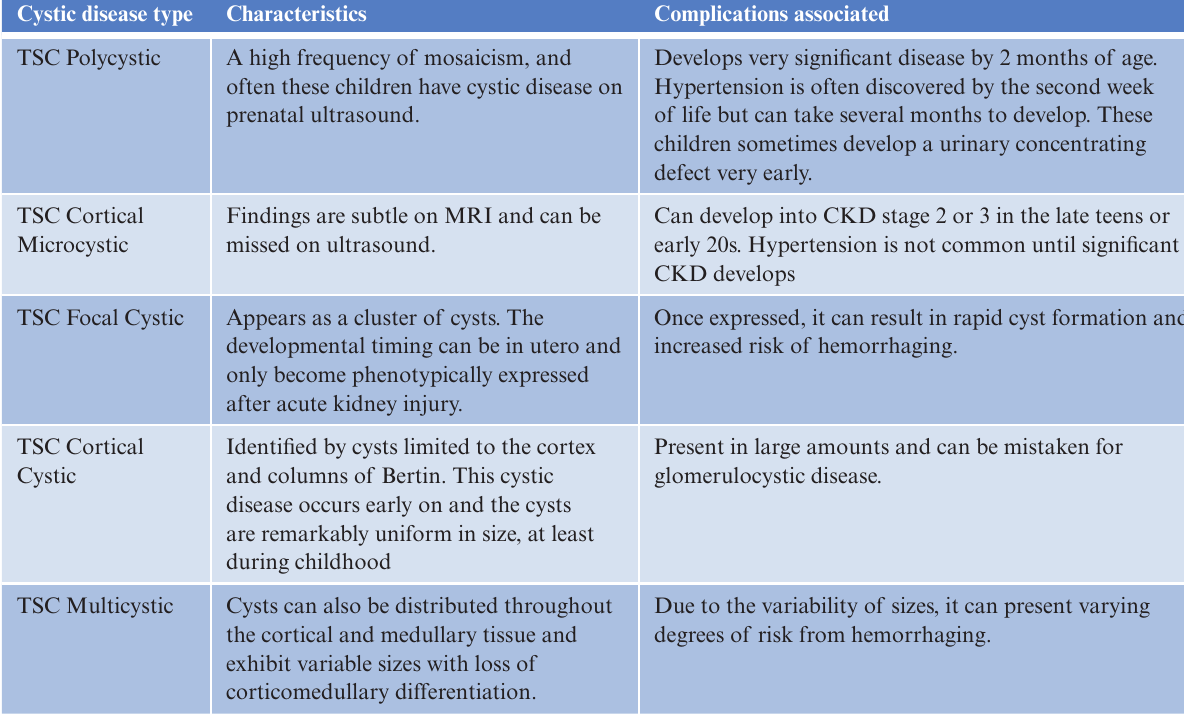
Table 5: Cystic subtypes seen in TSC. Cystic disease